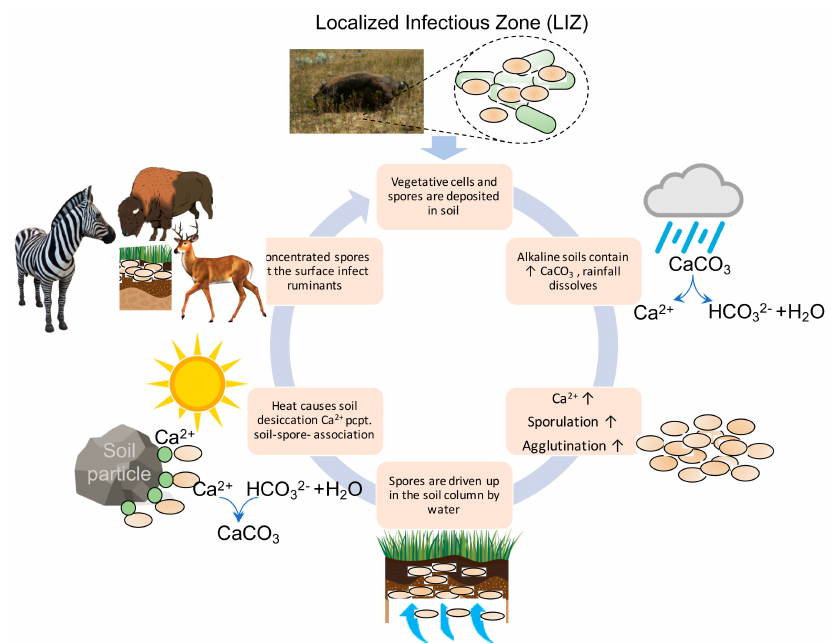
Figure 6. Rainfall, calcium and pH cycling, anthrax microecology and the phenology of anthrax outbreaks. At the top of the cycle, vegetative and sporulated B. anthracis are deposited in soil form an anthrax infected animal carcass forming a localized infectious zone (LIZ). Moving clockwise through the figure; if bacteria are deposited in calcium rich alkaline soils, bacterial survival and sporulation are promoted. Rainfall dissolves the mineralized calcium further inducing sporulation and causing bacterial agglutination. Agglutinated spores are likely driven back up through the soil column during regionally heavy rainfall. When hot dry conditions return, desiccation causes spores to attach via ionic interactions to soil particles. Concentrated spores at the surface and reduced food sources during seasonal heat-maxima bring animal hosts into close contact with infectious spore doses. Animals become infected and the cycle